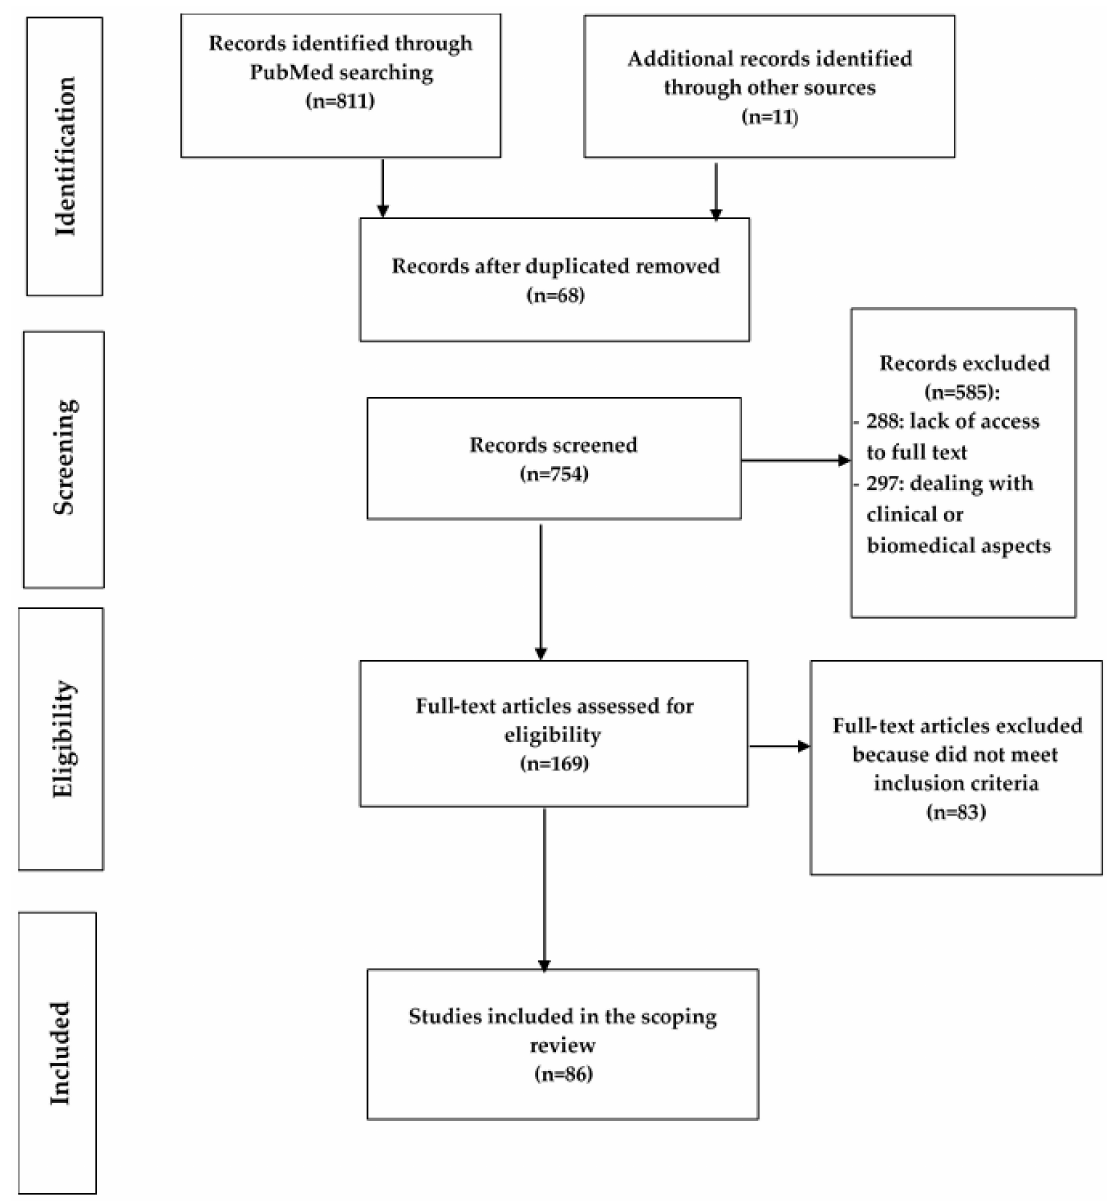
Figure 1. PRISMA diagram of the literature search